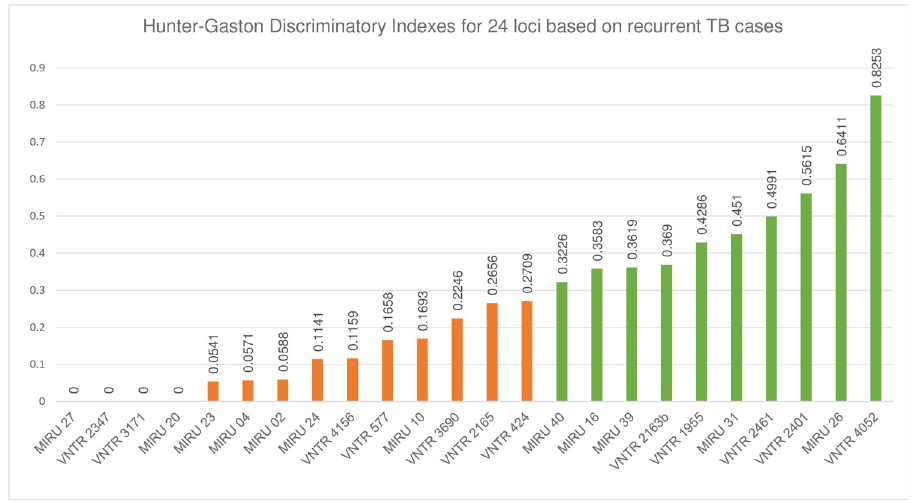
Fig 2. HGDI scores of 24-loci panel based on recurrent TB cases. Graph represents individual discriminatory index for 24-loci panel generated from recurrent TB cohort typing results. Green bars indicate “the Georgian customized set” with high and moderate index loci included in the customized